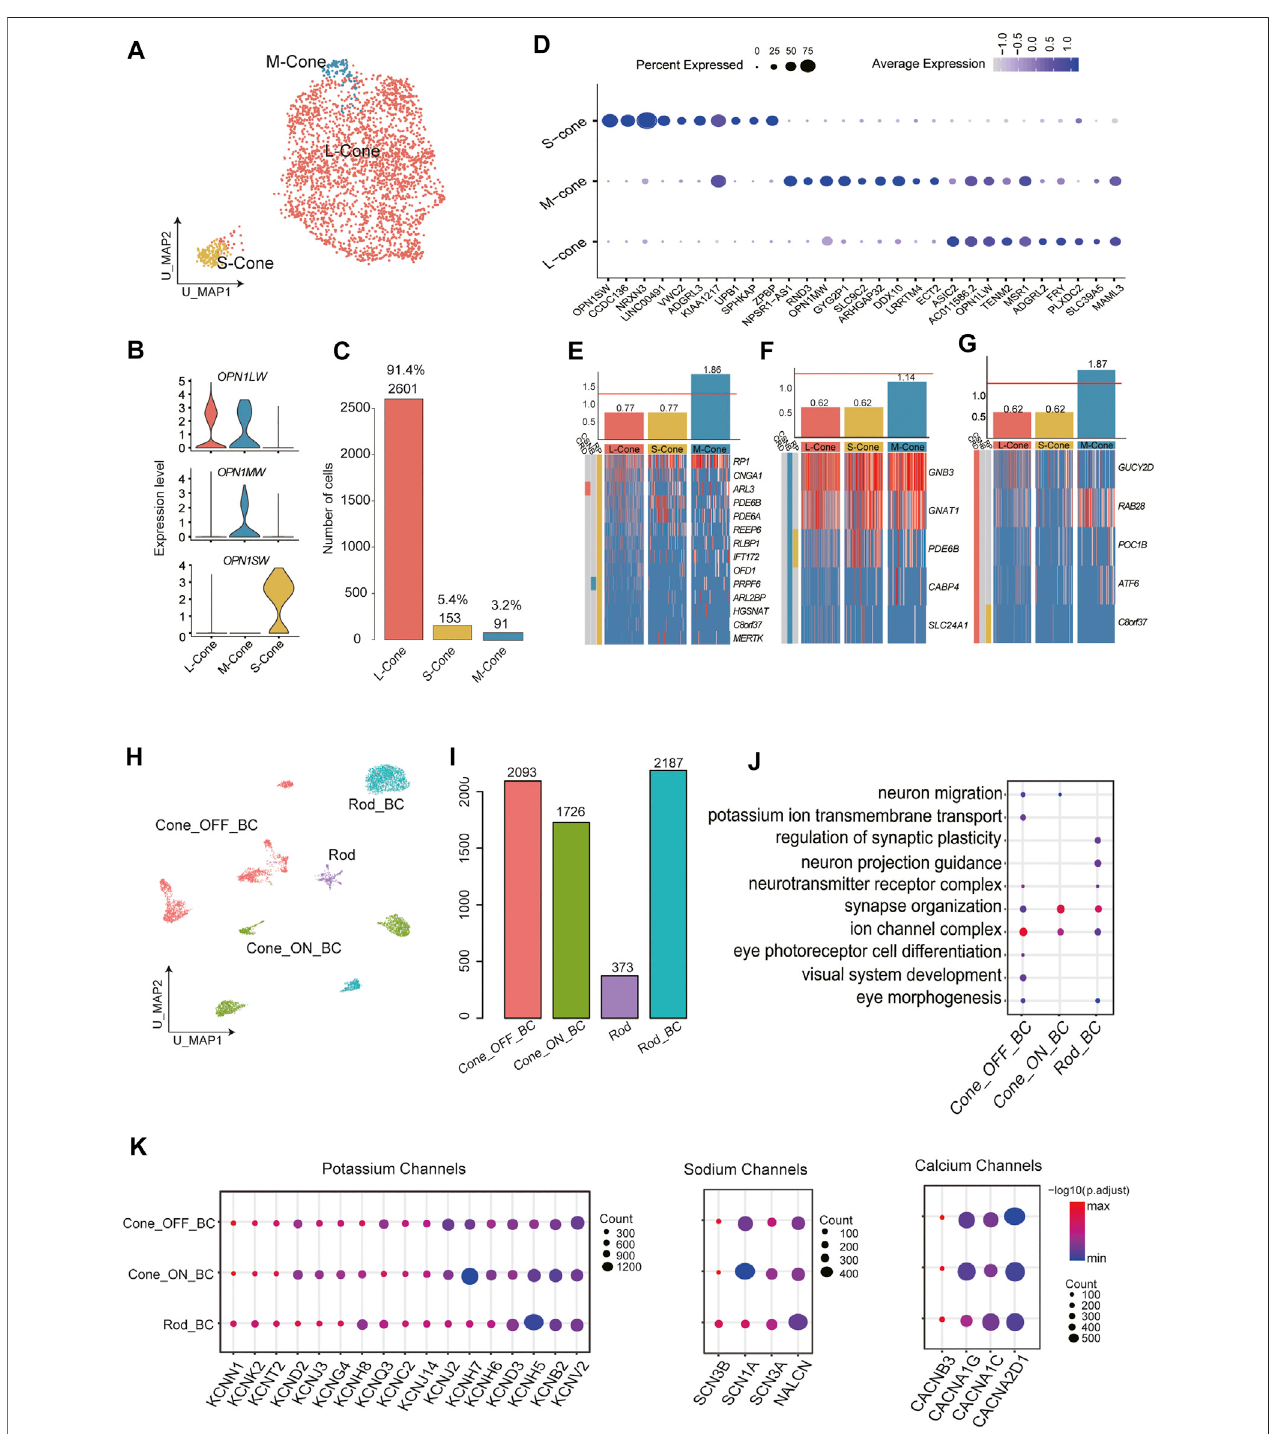
FIGURE 3 | Cellular diversity within cone PRs and BCs. (A) A UMAP of cone PRs single-cell data. Cells are colored by cluster (subtypes). (B) Annotation of cone subclusters: expression of three opsins (OPN1SW, OPN1MW, and OPN1LW) in three cone subclusters (C) Barplot showing the number of each cell type in cone subclusters. (D) Bubble plot showing the expression of differentially expressed genes in each cluster. Dot size represents the percentage of cells expressed corresponding gene and color represents the expression level. (E) Cone subtype enrichment of RP, (F) CSNB, and (G) CRD risk genes, respectively. Heatmap: expression of corresponding disease risk genes in cell subtypes. Cells are ordered by cluster. Bar graphs: numbers indicate log2 p value. The red line indicates signi fi cance. (H) A UMAP map of BCs single-cell data. Cells are colored by cluster (subtypes). (I) Barplot showing the number of each cell type in the whole dataset of bipolar subtypes. (J) Enriched GO terms in BC subclusters. Dot size denotes the gene ratio and color denotes the adjusted p value. (K) Bubble plot showing speci fi c expression ofPotassium,Sodium,andCalciumchannelsencodinggenesinBCsubclusters.Dotsizerepresentsthepercentage ofcellsexpressedcorrespondinggene and color represents the expression level.